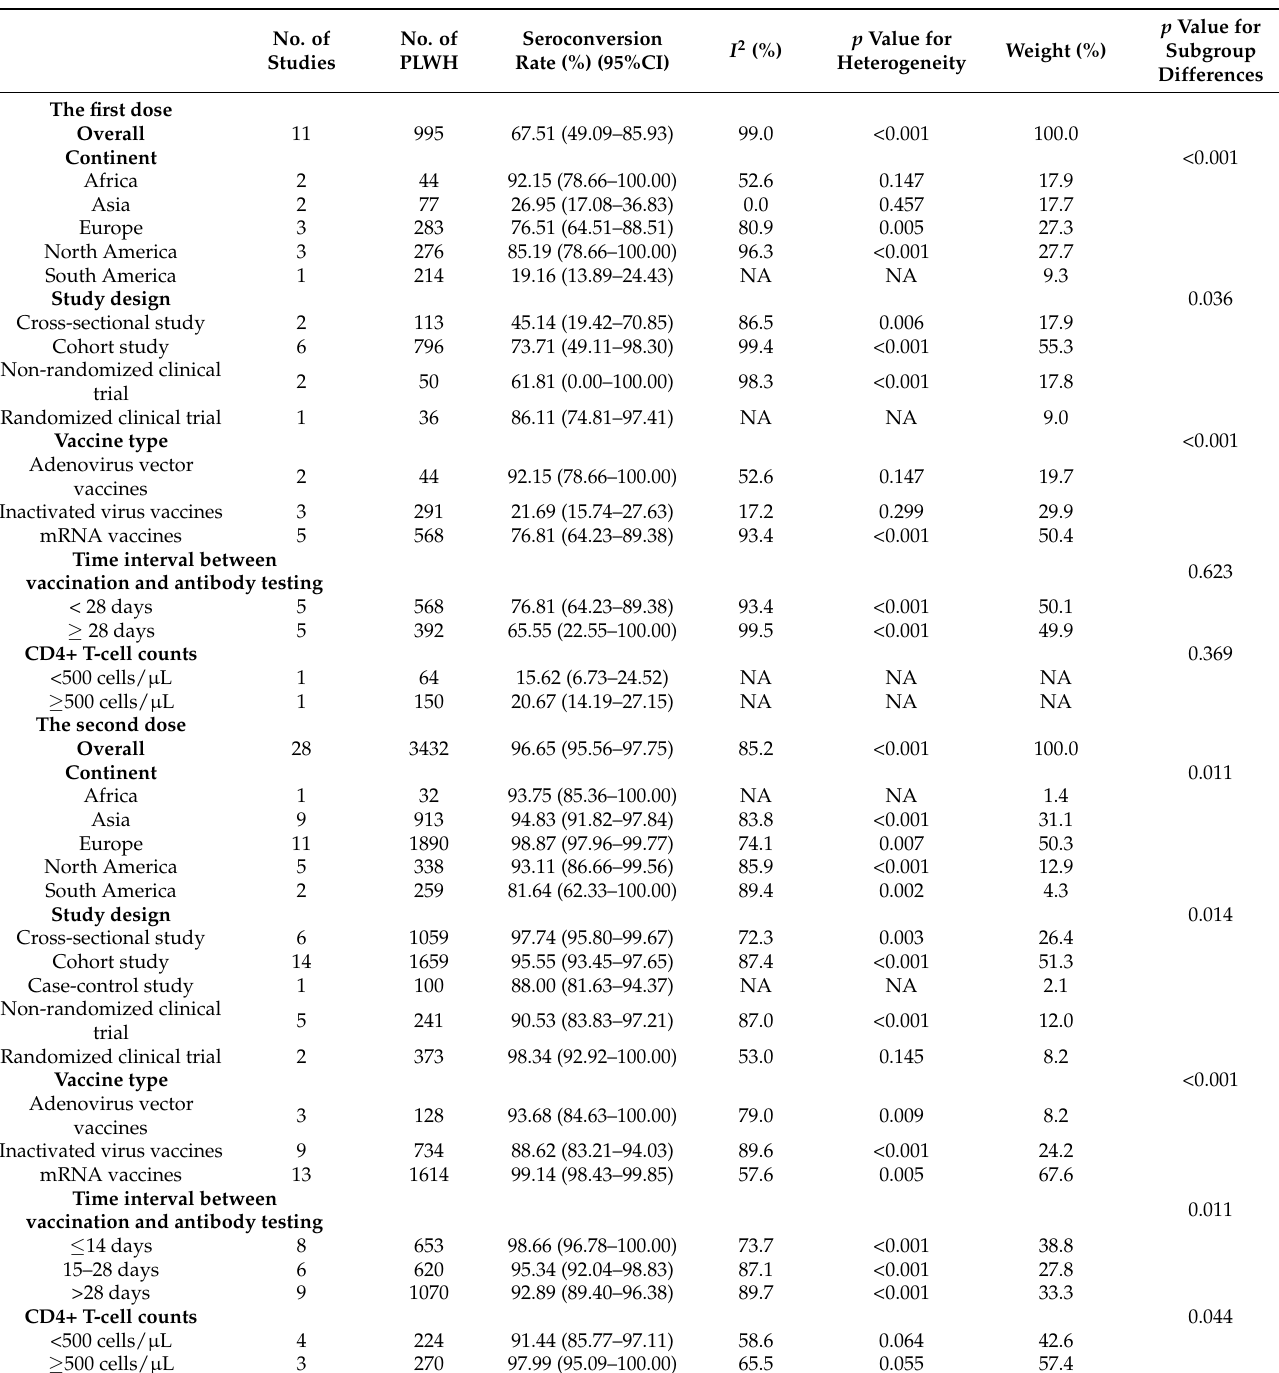
Table 1. The seroconversion rates of SARS-CoV-2 antibodies among people living with HIV by